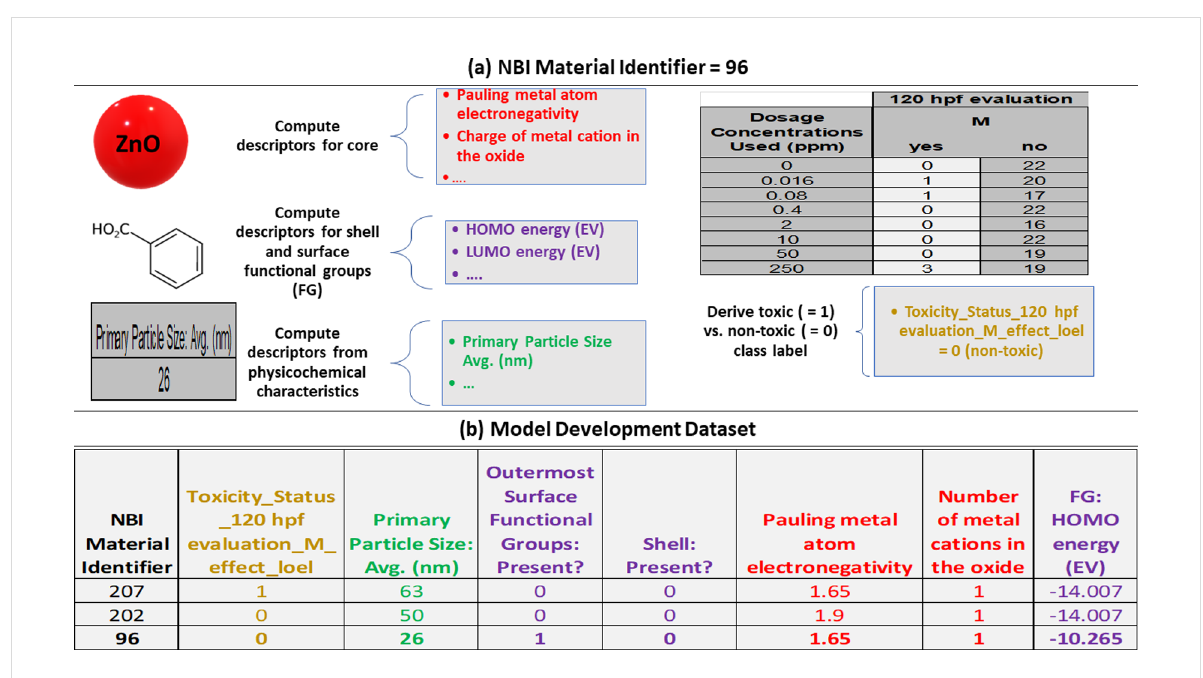
Figure 2: The transformation of the raw biological counts data, illustrated here for excess lethality at 120 hpf, and ENM core and surface chemical composition data, along with other reported physicochemical characteristics, into the modelled categorical endpoint data and the descriptors used to model them respectively. (a) This process is illustrated for the ENM corresponding to NBI Material Identifier 96 (coated zinc oxide with benzoic acid outermost surface functional groups). (b) A subset of the resultant model development dataset is shown, including three of the modelled ENMs and a subset of the descriptors used to model excess lethality at 120 hpf. Dummy values were assigned for the shell and/or outermost surface functional group descriptors if no shell and/or outermost surface functional groups were